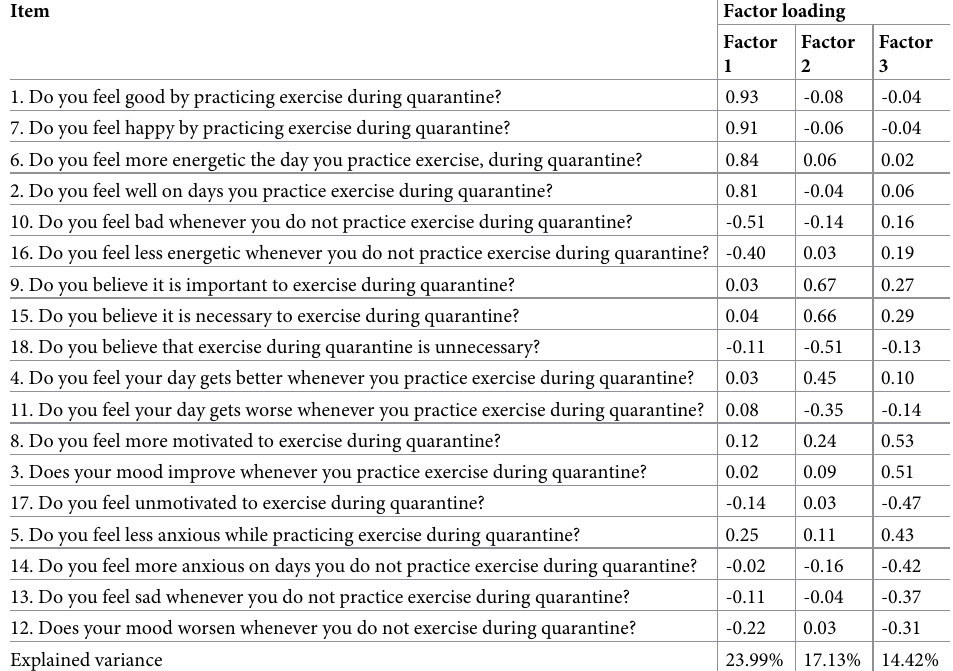
Table 4. Exploratory factor analysis of the